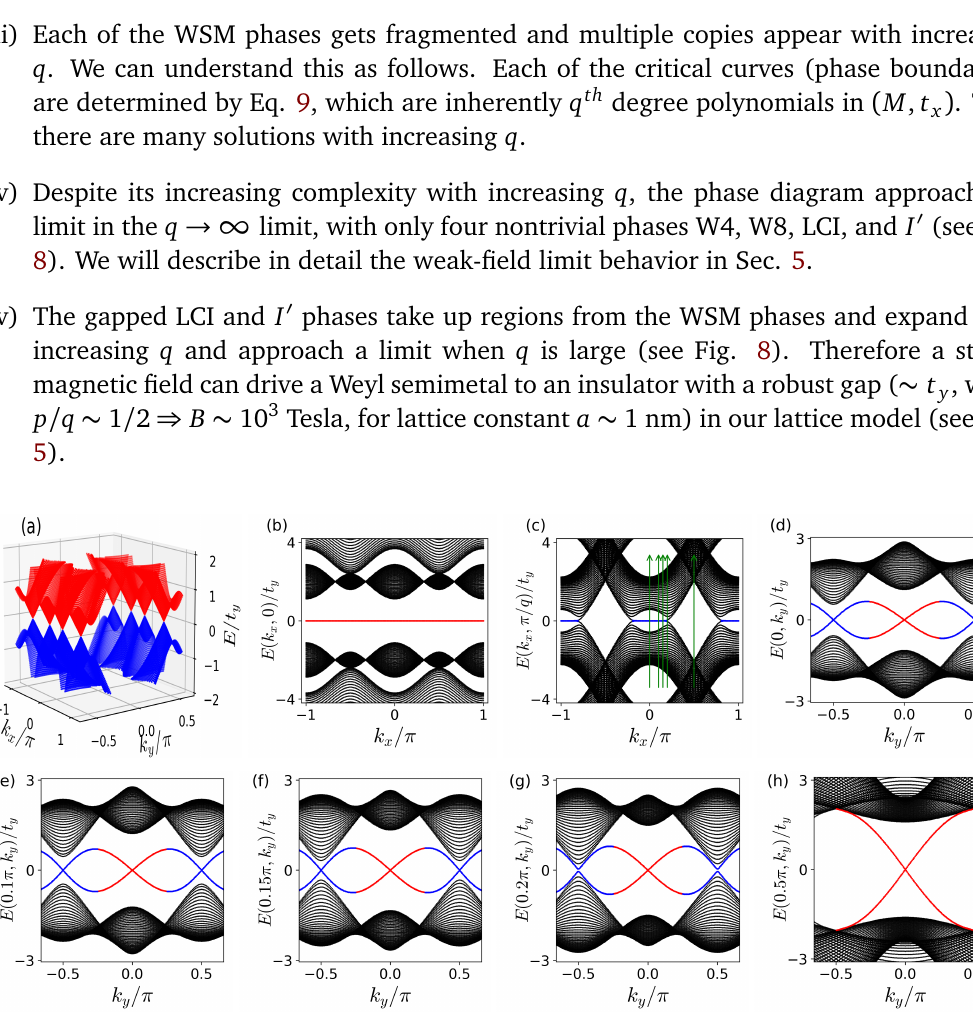
Figure 3: Bulk and surface spectrum in the W2 (cid:48) phase for q = 2, for M = 1.2 t y = 1.3 t and t . (a) The bulk bands around zero energy show 2 q = 4 Weyl nodes x y = ± π/ q , k = 0). In (b)-(h) which live at the boundary of the magnetic BZ ( k y z the spectrum along k and k directions is shown for the WSM slab (finite in the z - x y = 40). (b)Spectrum along k = 0 shows the surface direction with L for a fixed k z x y states (in red) which are not connected to the bulk Weyl node projections and span = π/ q shows the Fermi arc the magnetic BZ. (c) Spectrum along k for a fixed k x y surface states (in blue) connecting the bulk Weyl node projections. (d)-(h) Spectrum along k for a series of values of k (indicated in (c) by vertical green arrows) shows y x = ± π/ q the existence of two types of surface states. The surface states around k y correspond to the Fermi arc surface states which are connected to the bulk Weyl = 0 are the additional surface states node projections, whereas those around k y unconnected to the bulk. The red and blue shadings are meant for visualizations = 0 and k = 0.5 π respectively. As the Weyl point of the surface states around k y y projection is approached, the associated Fermi arc surface states start to mix with the bulk states (see figure (g)) and the decay length will diverge when we hit the Weyl node. In (h) we have only one type of surface states. The decay length of the surface = 0 and 0.5 π is states (shown in Figs. 3e-h) for a series of k values in between k y y plotted in Fig.